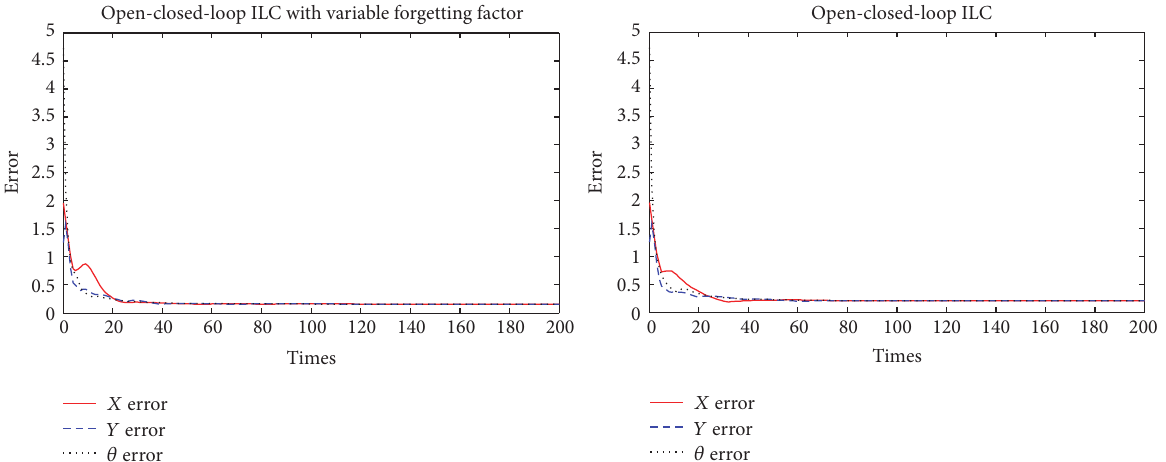
Figure 3: Max absolute values of the tracking error.